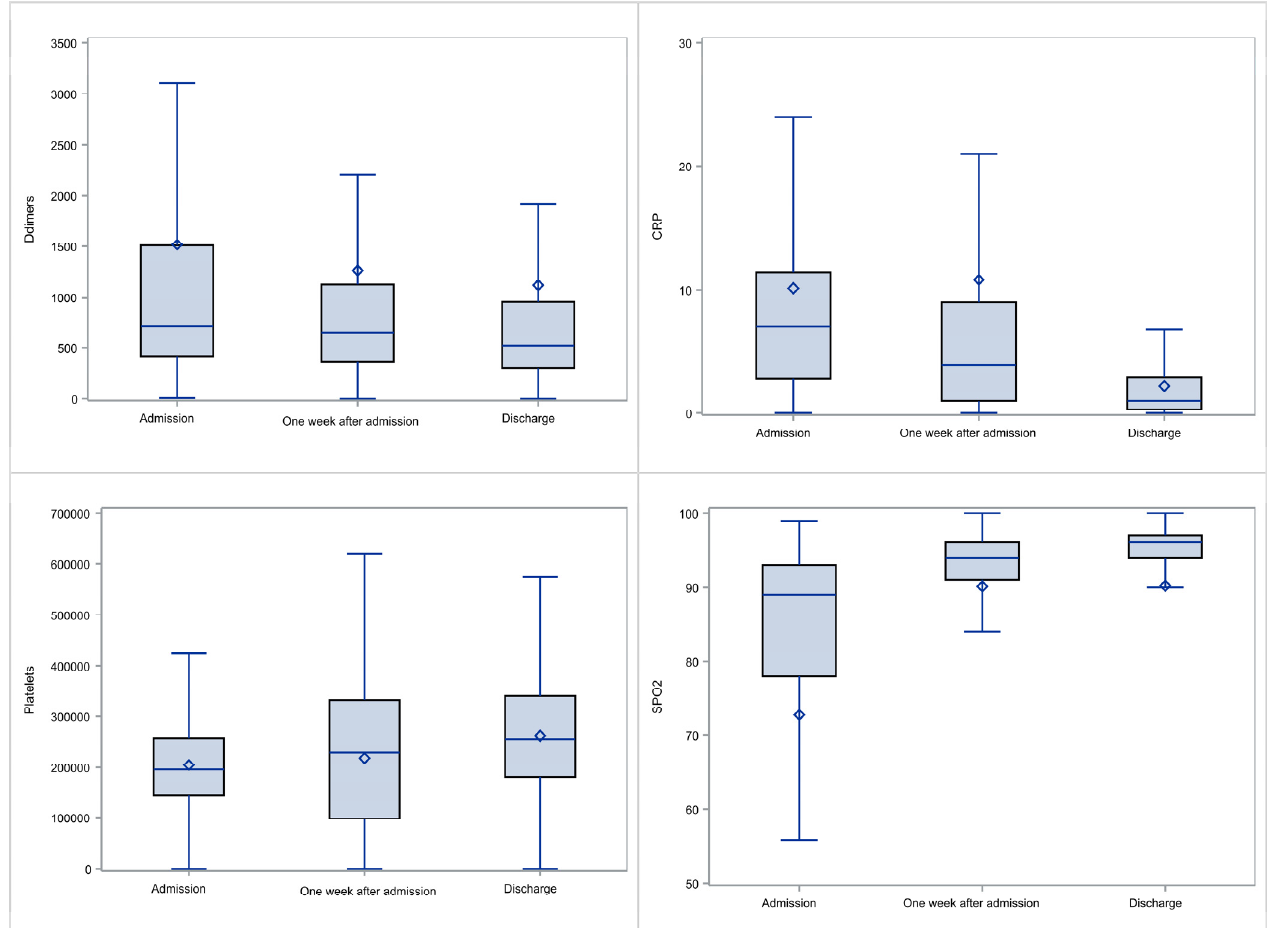
Figure 1. Evolution of D-Dimers, CRP, PLTs and SpO2 from admission to discharge. In each plot the lower and upper part of the boxes represent the Q1 and Q3 values; horizontal lines within the boxes correspond to the median values; the whisker limits correspond to the lower an upper value after excluding outliers; and the diamond symbols represent the mean value. Outliers are not pre- sented.